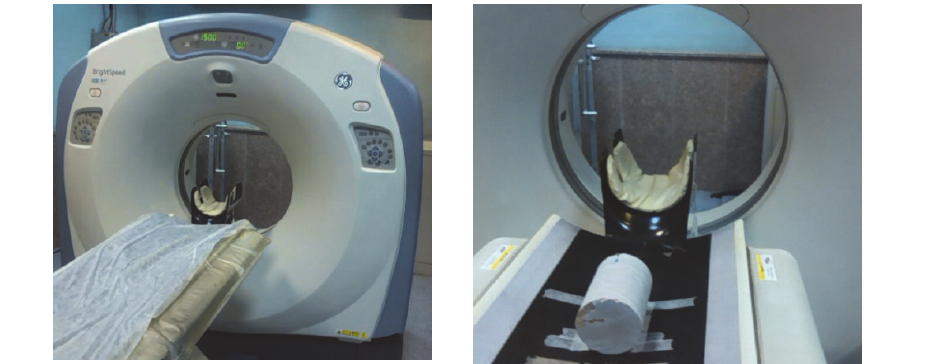
Figure 3: CT-Scan devise